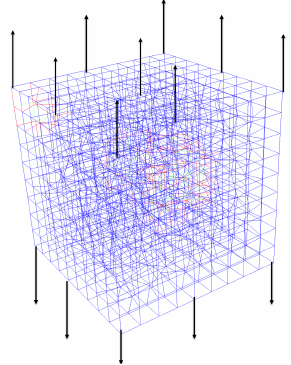
Figure 5. Uniaxial tension numerical test based on the lattice model.